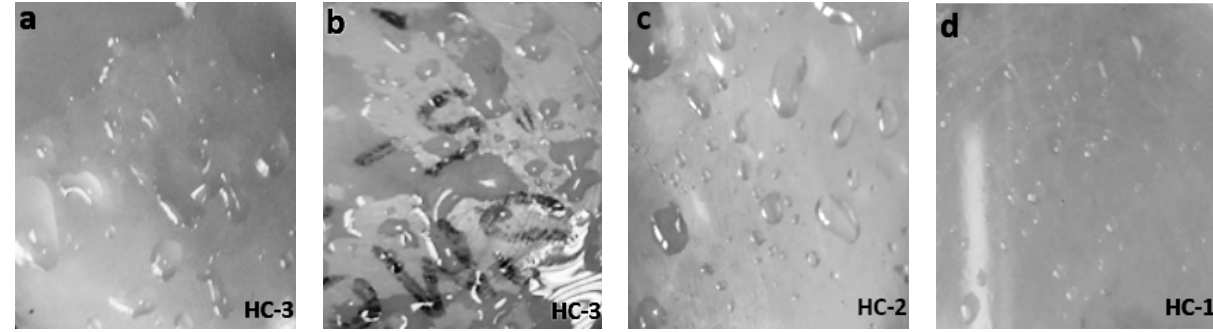
Figure 4. Images of aged (200 h) ( a ) nSiR ( b ) SMC 15 ( c ) SNC 2.5 and ( d ) SNC Figure 4: Images of aged (200 h) ( a ) nSiR ( b ) SMC 15 ( c ) SNC 2.5 and ( d ) SNC 5. Figure 4: Images of aged (200 h) ( a ) nSiR ( b ) SMC 15 ( c ) SNC 2.5 and ( d ) SNC 5. Figure 4: Images of aged (200 h) ( a ) nSiR ( b ) SMC 15 ( c ) SNC 2.5 and ( d ) SNC 5.